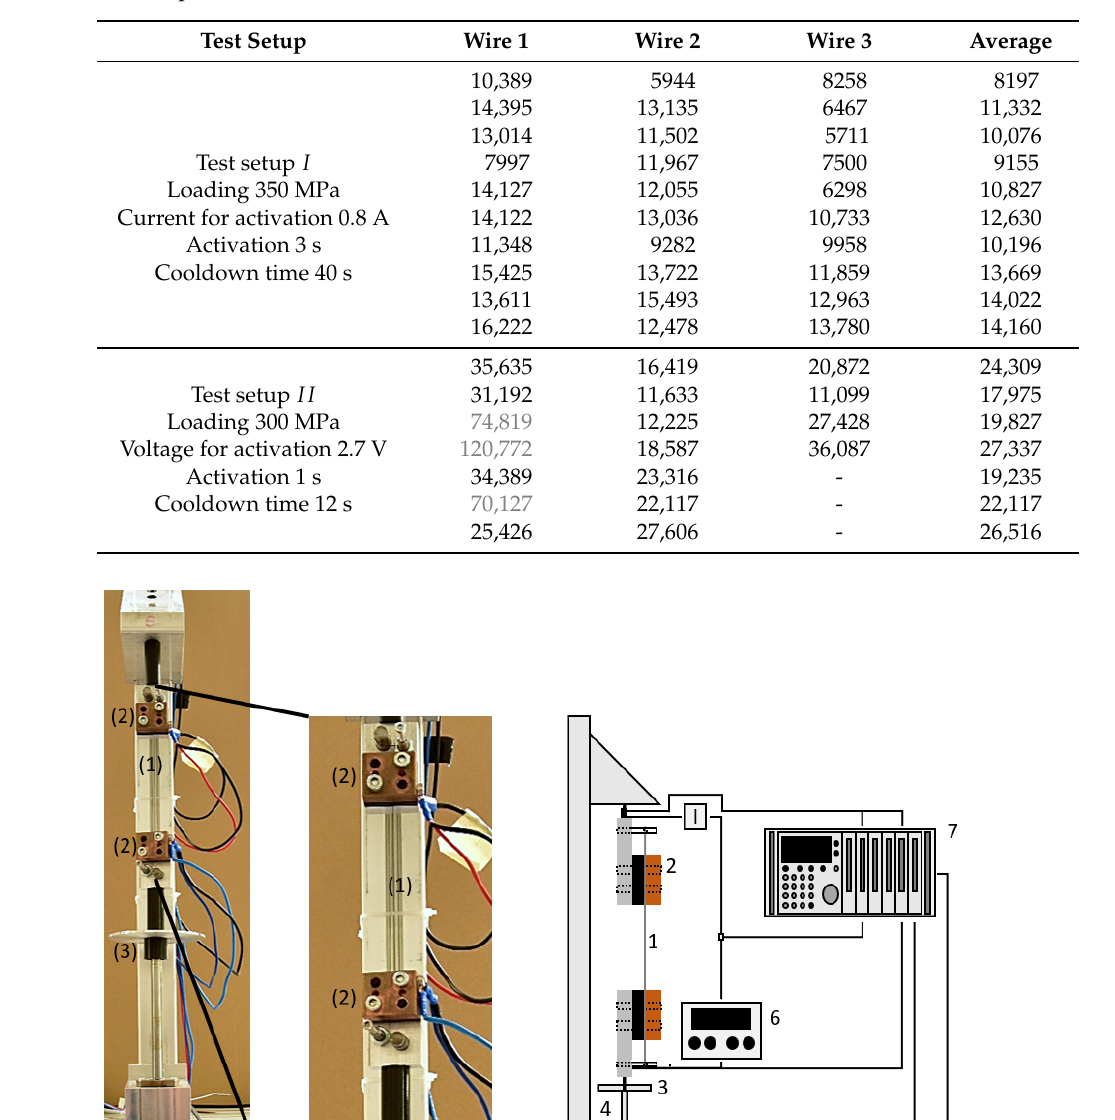
Table 1. Results of the fatigue tests performed: Cycles till failure of all tested wires for 2 different test setups.